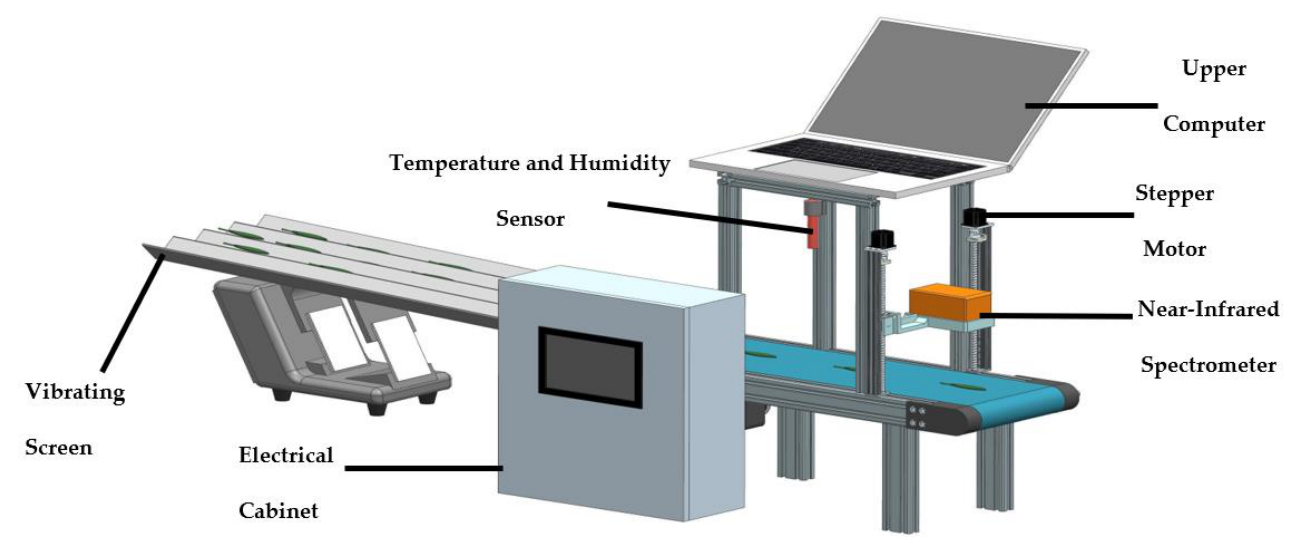
Figure 1. Online monitoring system overall design diagram.